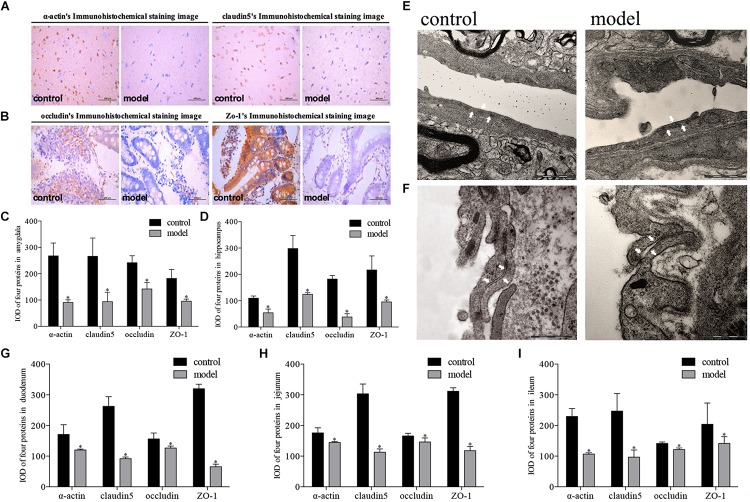
Impact of psychological-stress stimulation on tight junction proteins in intestinal and blood–brain barriers. (A,C–E) Decreased expression of tight junction proteins in the amygdala and hippocampus. (A) Representative immunohistochemical staining of α-actin and claudin5 in the amygdala (model and control markers are located in the lower right corner of the image). (C) IOD values for expression levels of four proteins in the amygdala. (D) IOD values for expression levels of four proteins in the hippocampus (light gray: control; dark gray: model; n = 5, each group). (E) Representative electron microscopy pictures of tight junctions of the BBB in the amygdala (tight junction indicated by white arrow; n = 3, each group). (B,F–I) Decreased expression of tight junction proteins in duodenum, jejunum, and ileum. (B) Representative immunohistochemical staining of occludin and ZO-1 in the duodenum (model and control markers are located in the lower right corner of the image). (F) Representative electron microscopy pictures of tight junctions of the intestinal barrier in the duodenum (tight junction indicated by white arrow; n = 3, each group). (G) IOD values for expression levels of four proteins in the duodenum. (H) IOD values for expression levels of four proteins in the jejunum. (I) IOD values for expression levels of four proteins in the ileum (light gray: control; dark gray: model; n = 5, each group). Data shown as mean ± SD; ∗P < 0.01, model group vs. control group.